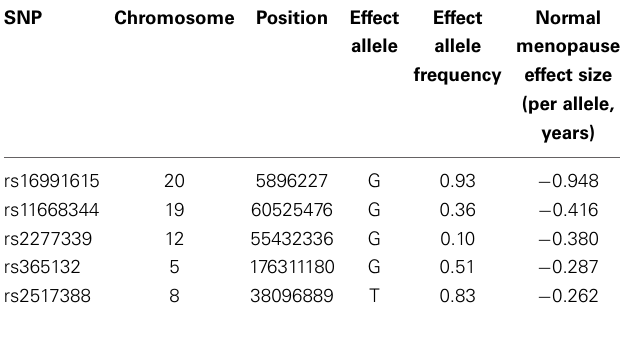
Table 3 | SNPs known to influence age at menopause (data taken from Stolk et al., 2012 and Perry et al., 2013). SNP